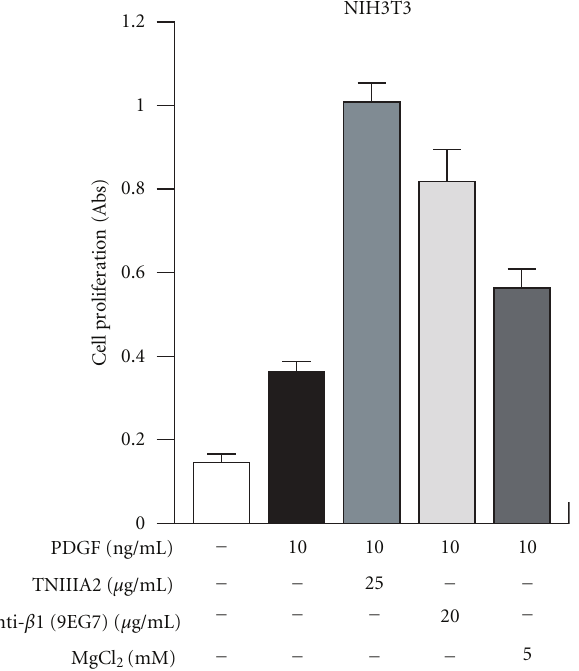
Figure 7: TNIIIA2 accelerates PDGF-induced cell proliferation. PDGF-induced cell growth was enhanced by addition of TNIIIA2, as well as administration with integrin activators (anti- β 1 and MgCl 2 ) (our unpublished